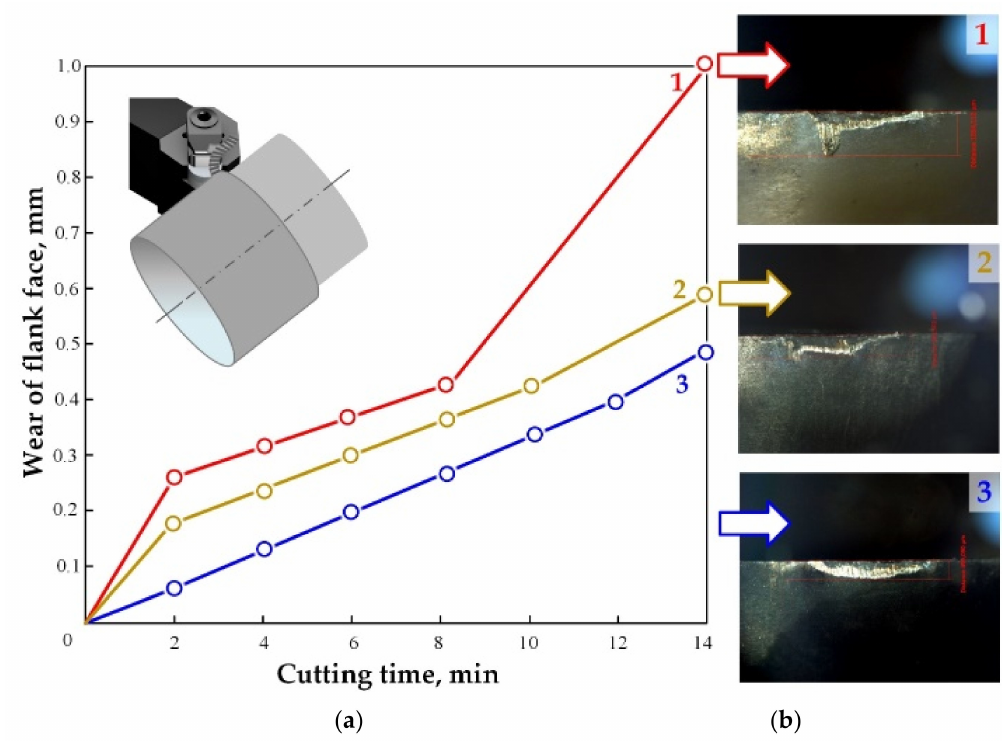
Figure 15. Experimental dependences of wear on the back surface of round SiAlON ceramic plates on the time of cutting a nickel–chromium alloy ( a ) and optical images of the worn areas of the plates after 14 min of operation ( b ): 1 —without coating, 2 —with TiAlN coating, 3 —with TiAlN coating deposited after removal of the defective surface